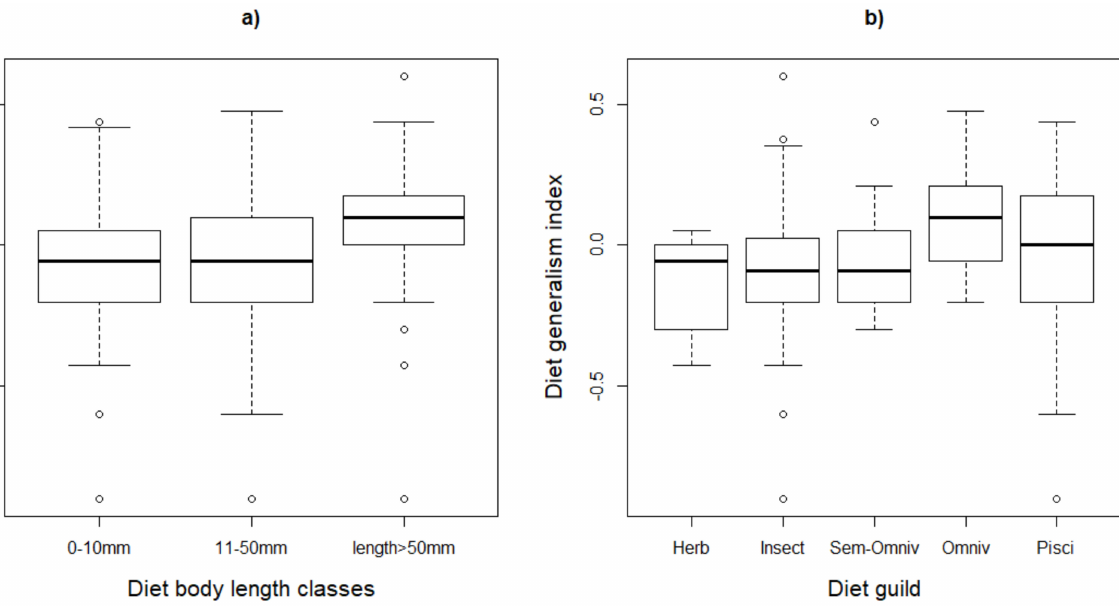
Figure 2. Variation of the diet generality index for waterbirds of southern Africa across their ( a ) diet body length classes and ( b ) diet guilds. The lines and bars represent the median and the quartiles. In plot ( b ), Herb = herbivores, Insect = insectivores, Omniv = omnivores and Pisci =